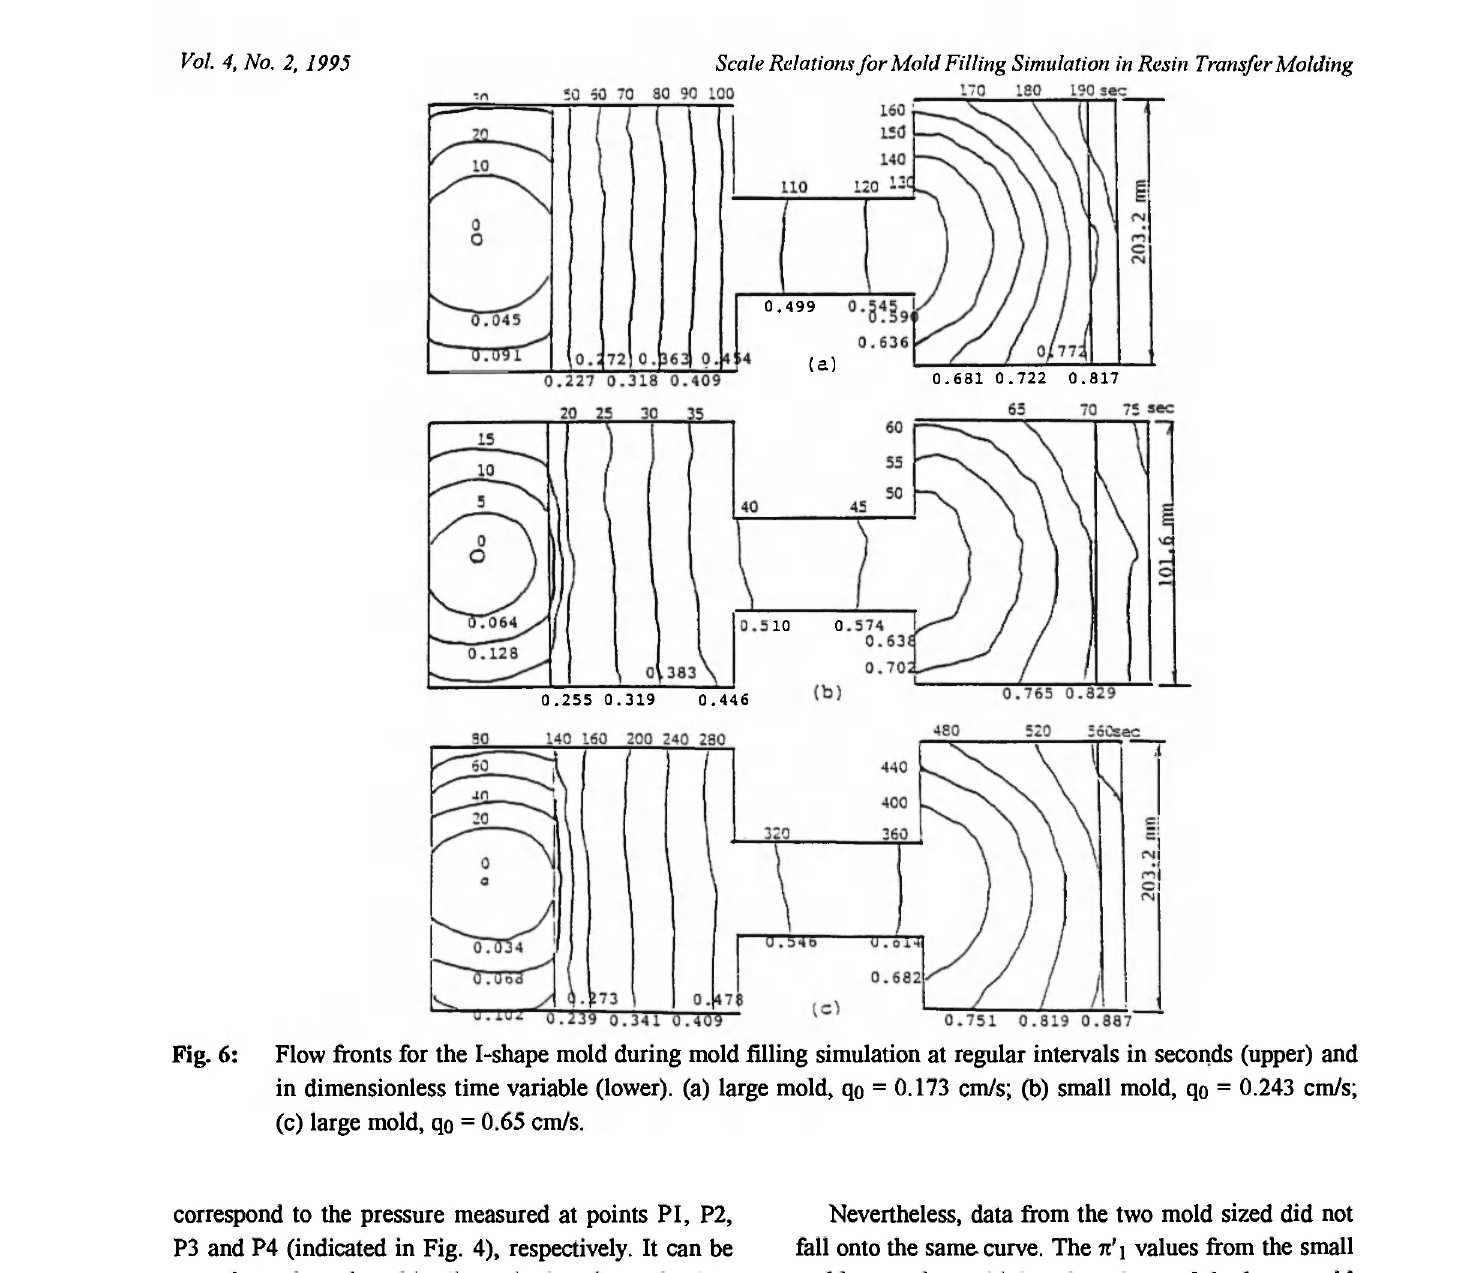
Fig. 6: Flow fronts for the I-shape mold during mold filling simulation at regular intervals in seconds (upper) and in dimensionless time variable (lower), (a) large mold, qo = 0.173 cm/s; (b) small mold, qo = 0.243 cm/s; (c) large mold, qo = 0.65